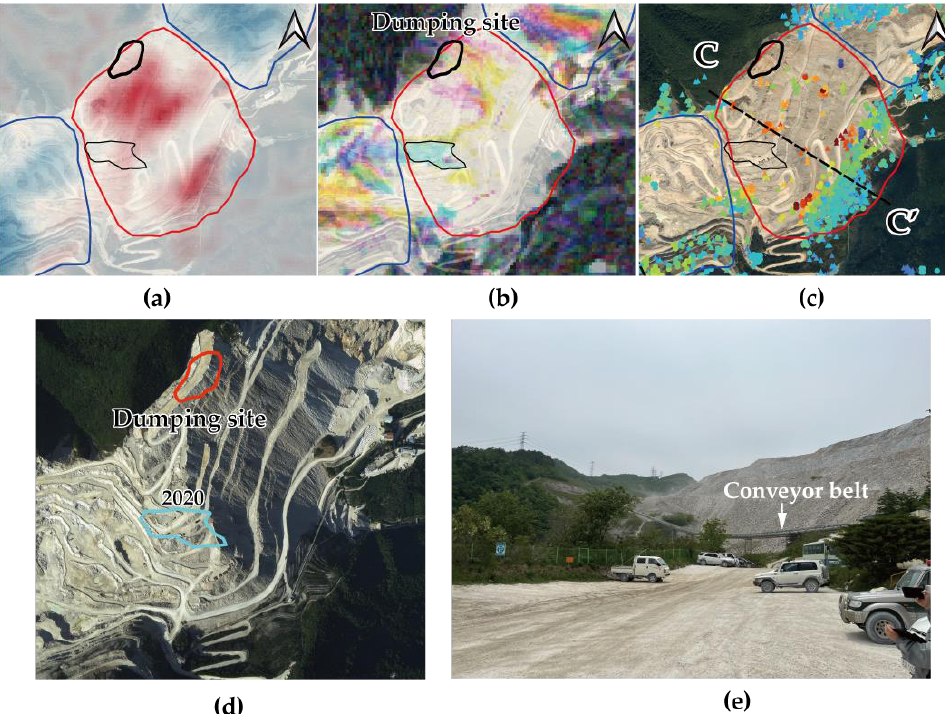
Figure 8. The resulting images of the tailings storage area. ( a ) Elevation change, ( b ) RGB composited coherence image, ( c ) PSInSAR points from ascending (triangle) and descending (circle) orbit overlying a Google Earth satellite image of 2019, ( d ) an aerial photograph of 2021 with polygons indicating recent dumping sites, and ( e ) a field photo taken in 2022.